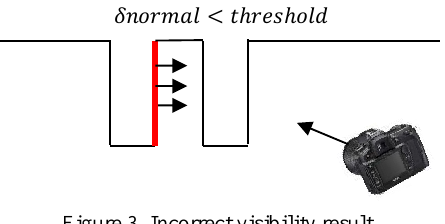
Figure 3. Incorrect visibility result